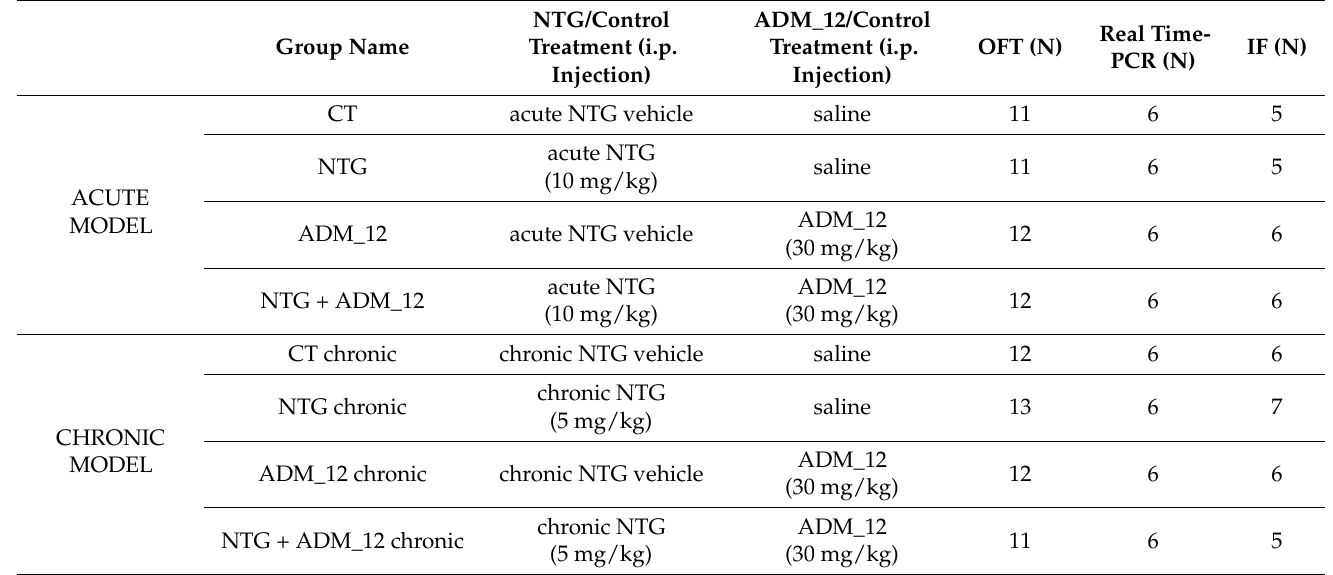
Table 1. Experimental groups within the acute and chronic NTG models with details of treatments and the number (N) of animal per group assigned to different experimental procedures and